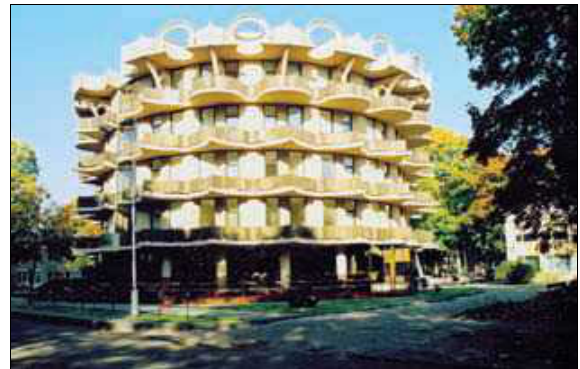
(autoriai a. ir r. Šilinskai, 1982 m.) Fig. 4. the second block of sanatorium “Sūrutis“ (authors: a. Šilinskas, r. Šilinskas,